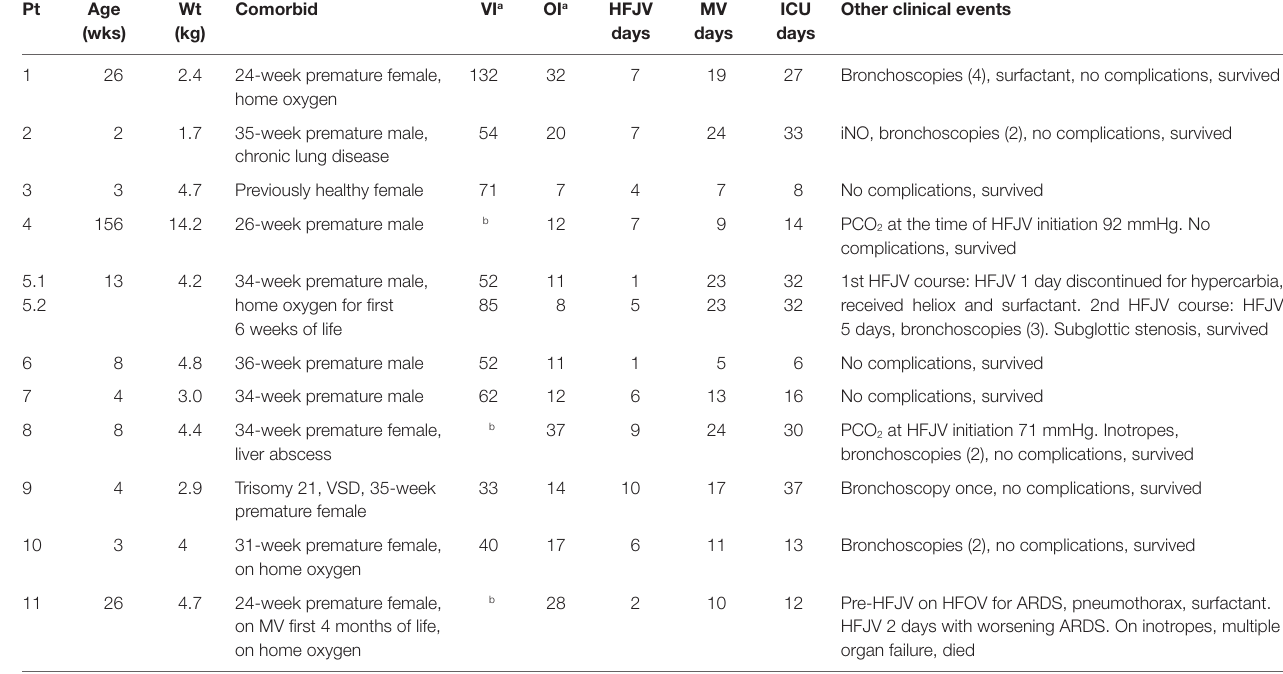
TaBle 1 | Patient characteristics and clinical course summary.